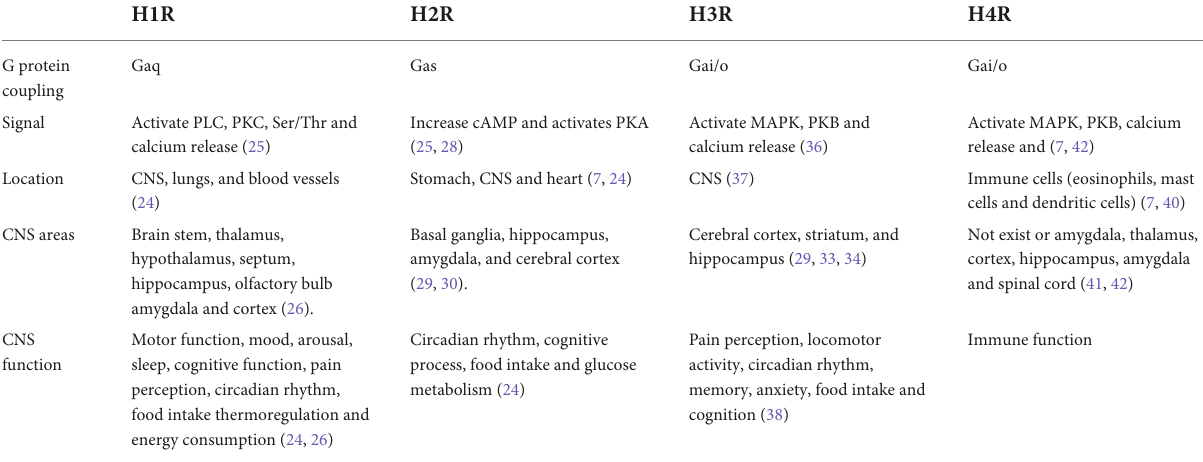
TABLE 1 Overview of histamine receptors in central nervous system